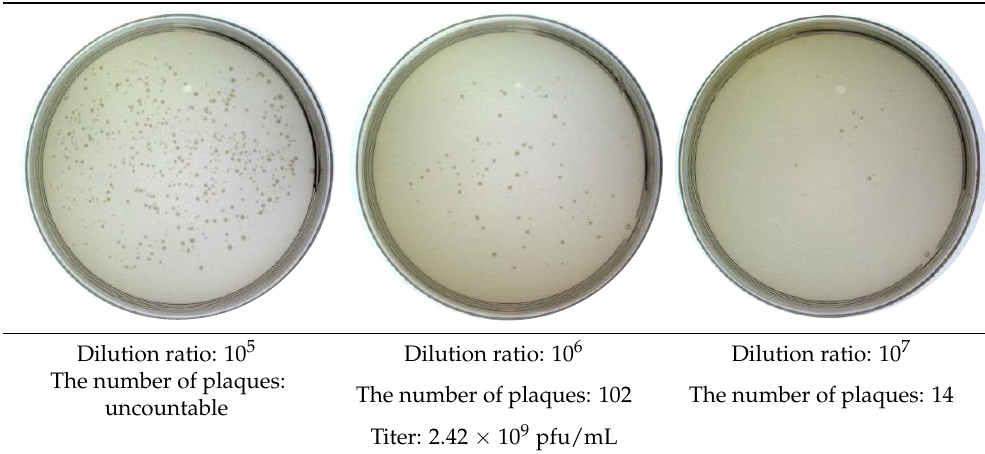
Table 1. Titer measurement of Model-S.